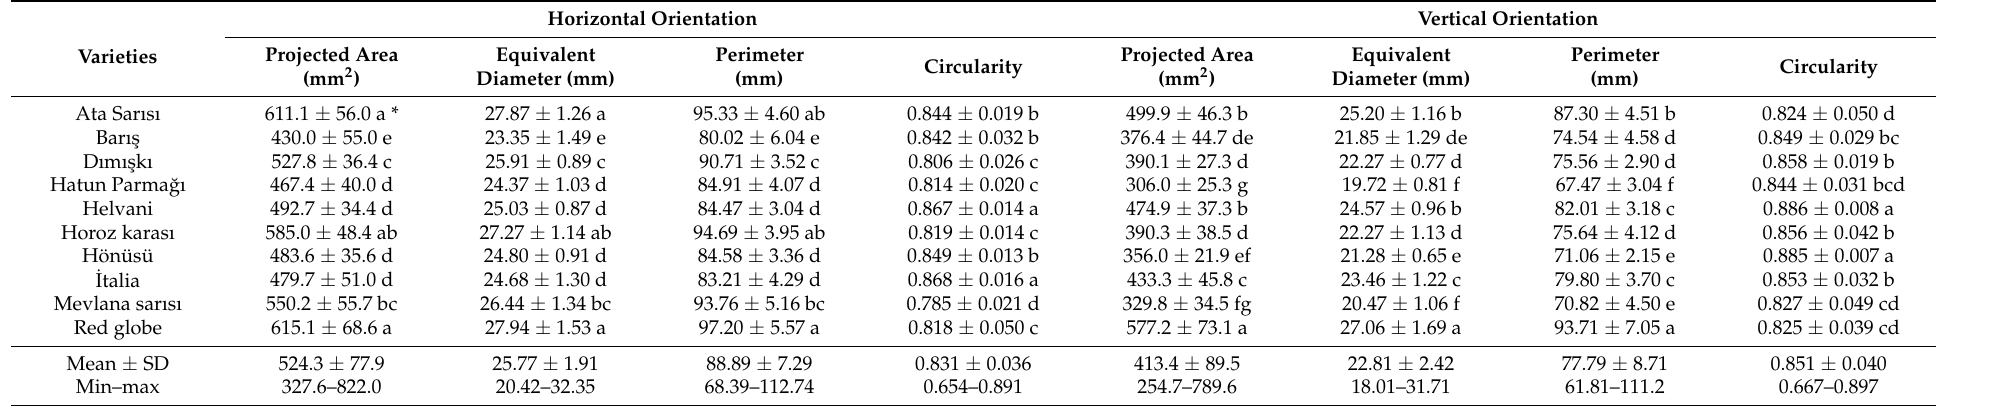
Table 2. Basic size and shape traits measured at horizontal and vertical orientations.